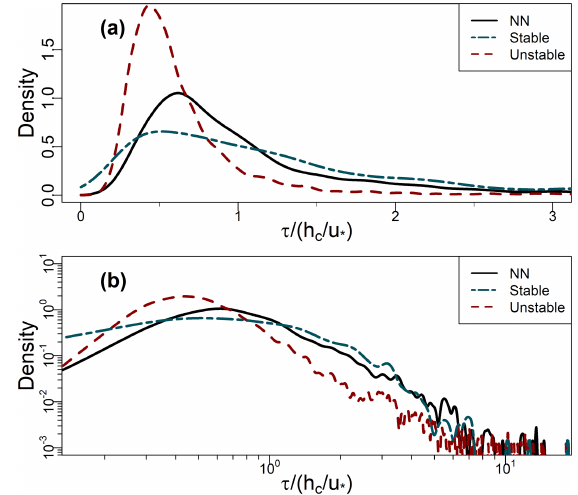
Figure B1. (a, b) PDFs of residence times (Sect. 2.3) binned by sta- bility class for the leaf-off period (Sect. 2.2), plotted on linear and logarithmic axes (base 10), respectively. NN denotes near-neutral conditions. See Sect. 2.6 for definitions and Fig. 7b and c for anal- ogous results from the leaf-on